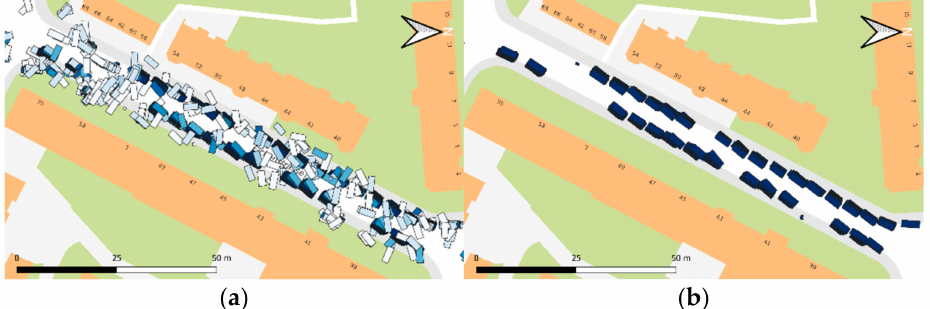
Figure 6. Result of the vehicle detection algorithm ( a ) and filtered result according to the probability score ( b ) (data source for background map: Geodaten Kanton Basel-Stadt).